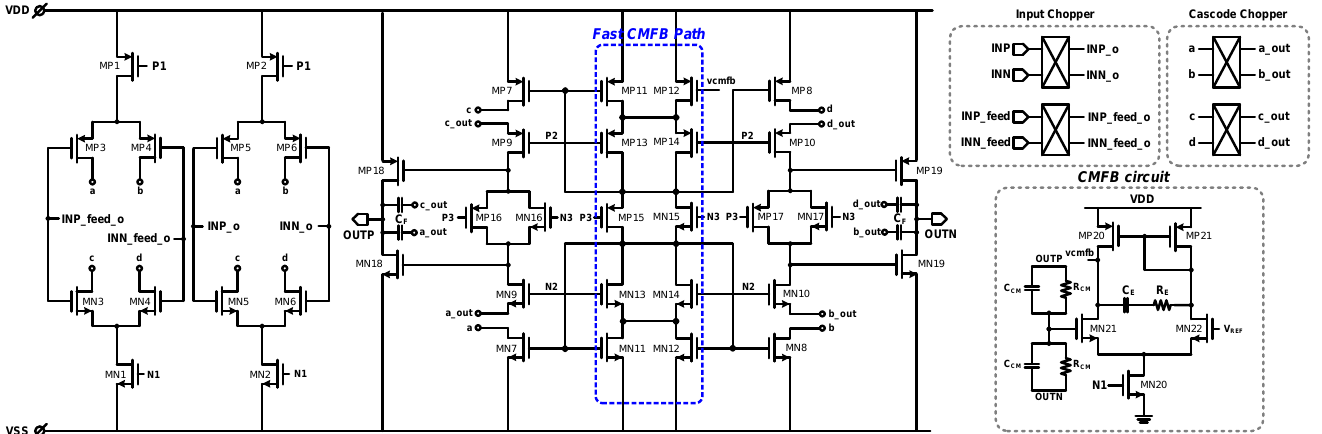
Figure 6. Schematic of the proposed chopper FDDA. Table 1. Values of transistors in the proposed FDDA.